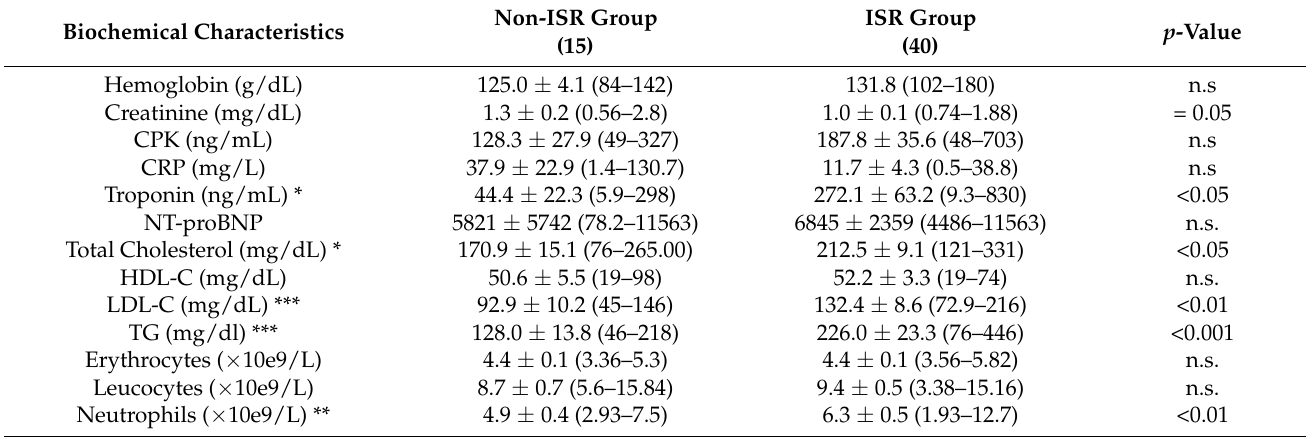
Figure 2. Hemodynamic parameters of the patient groups. Green and rose colors indicate non-ISR and ISR patients, respectively. Bar graphs show ( A ) the concentration of creatine, ( B ) neutrophils, ( C ) Troponin, ( D ) total cholesterol (TC), ( E ) Low-density Lipoprotein Cholesterol (LDL-C), and ( F ) triglycerides (TG) assessed in the serum sample collected from non-ISR and ISR patients. Values are the means ± S.E.M. “*” and “**” indicate significance at p < 0.05 and p < 0.001, respectively. Table 2. Data summary (mean ± S.E.M.) of the hemodynamic parameters from non-ISR and ISR patients evaluated during the second angiography. Creatinine, Creatine phosphokinase (CPK), C-Reactive Protein (CRP), N-terminal natriuretic peptide (NT-proBNP), Total Cholesterol (TC), High-Density Lipoprotein cholesterol (HDL-C), Low-density Lipoprotein Cholesterol (LDL-C), and triglycerides (TG). “*”, “**”, “***” indicate significance at p < 0.05, p < 0.01 and p < 0.001